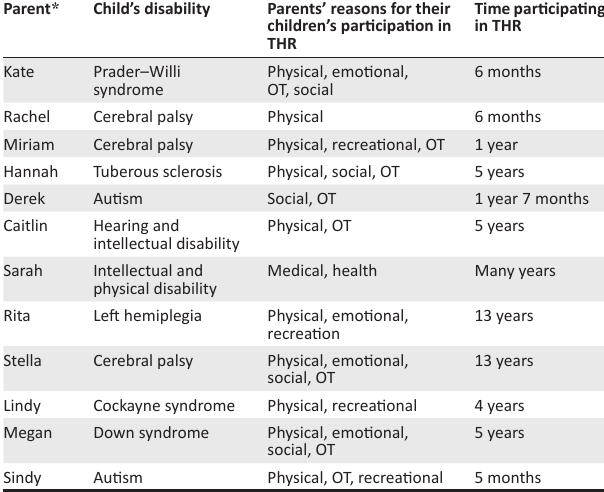
TABLE 1: Demographic information of